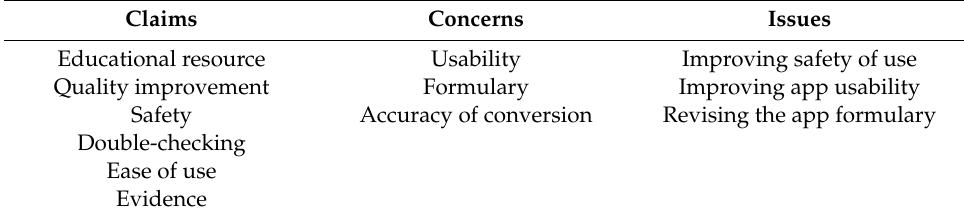
Table 3. Focus group feedback—claims, concerns and issues key